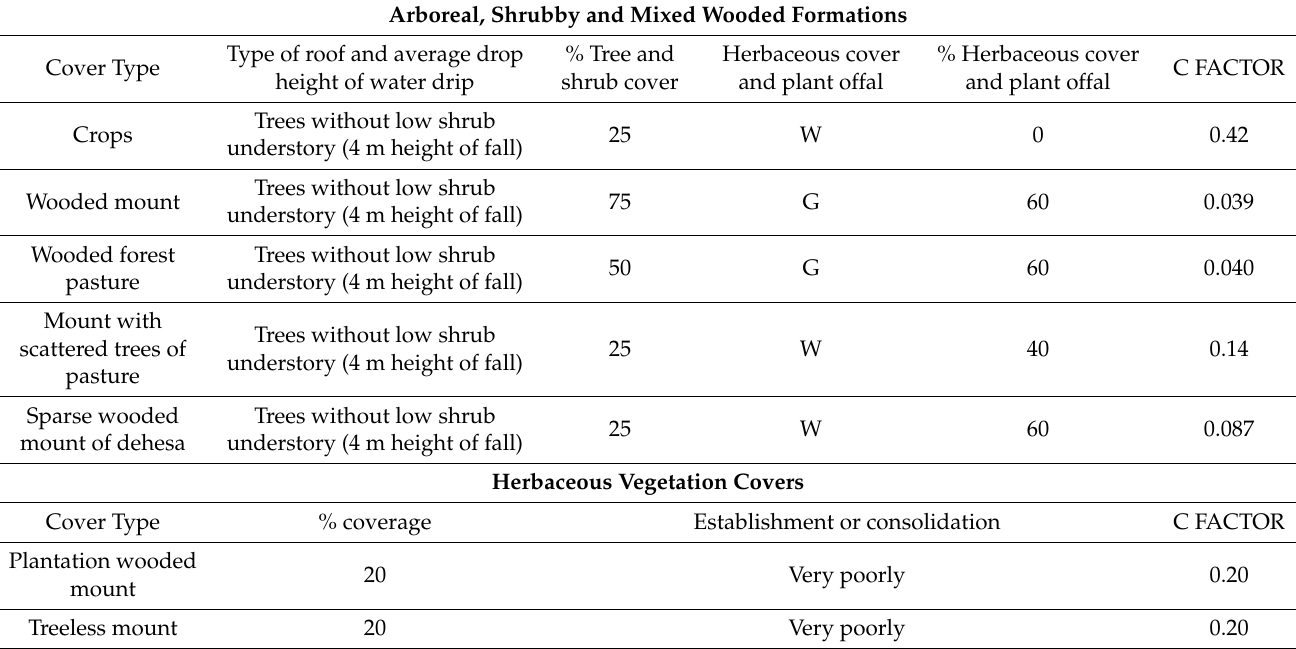
Table 2. Determination of factor C for arboreal, shrub, mixed wooded formations and herbaceous plant covers. Arboreal, Shrubby and Mixed Wooded